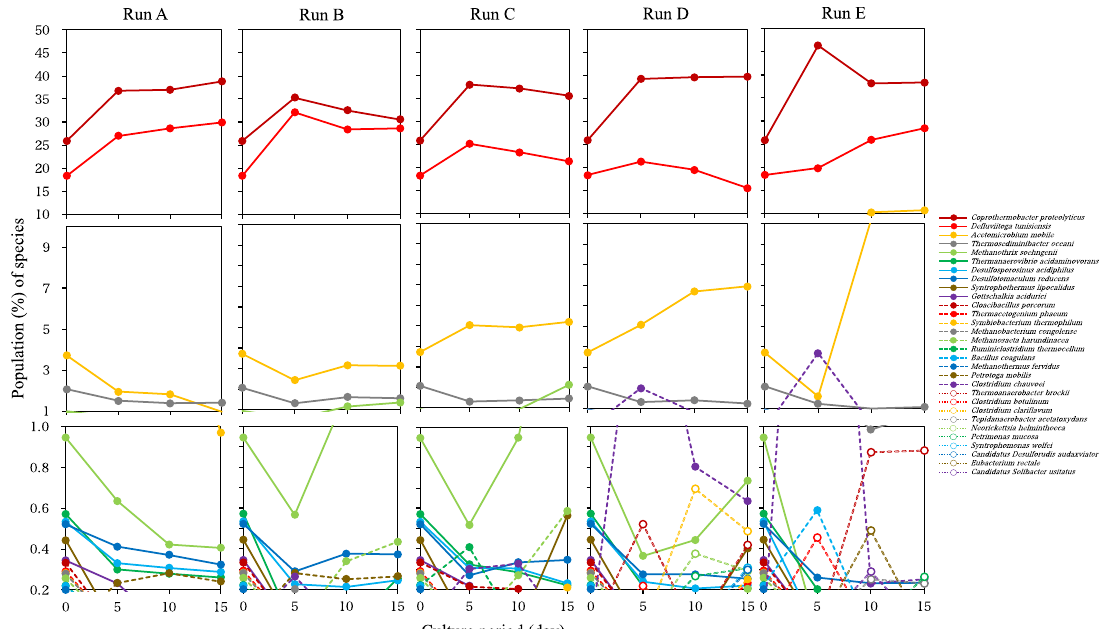
Figure 4. Changes in population of the species in runs A , B , C , D , and E . The species that amounted more than 0.2% population are shown.